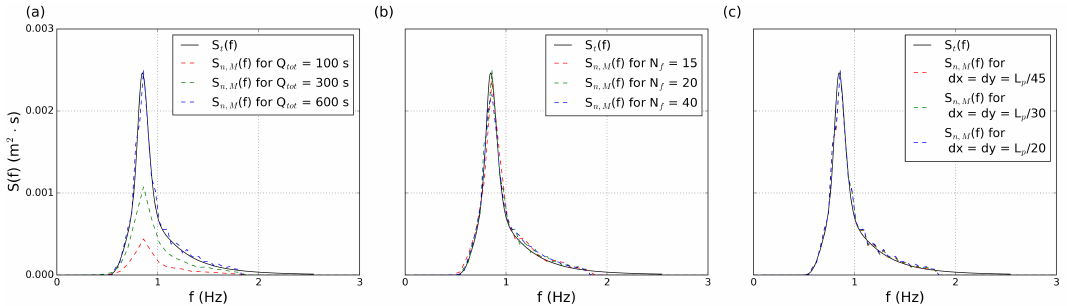
Figure 2. Numerical wave spectrum S n , M ( f ) generated at the centre of the MILDwave numerical domain for an irregular wave with T p = 1.26 s and H s = 0.104 m and different simulations parameters: ( a ) total simulation time, Q tot ; ( b ) number of regular wave components, N f and ( c ) grid cell size, d x (= d y ) . S n , M ( f ) is compared in ( a – c ) to the theoretical wave spectrum, S t ( f ) .